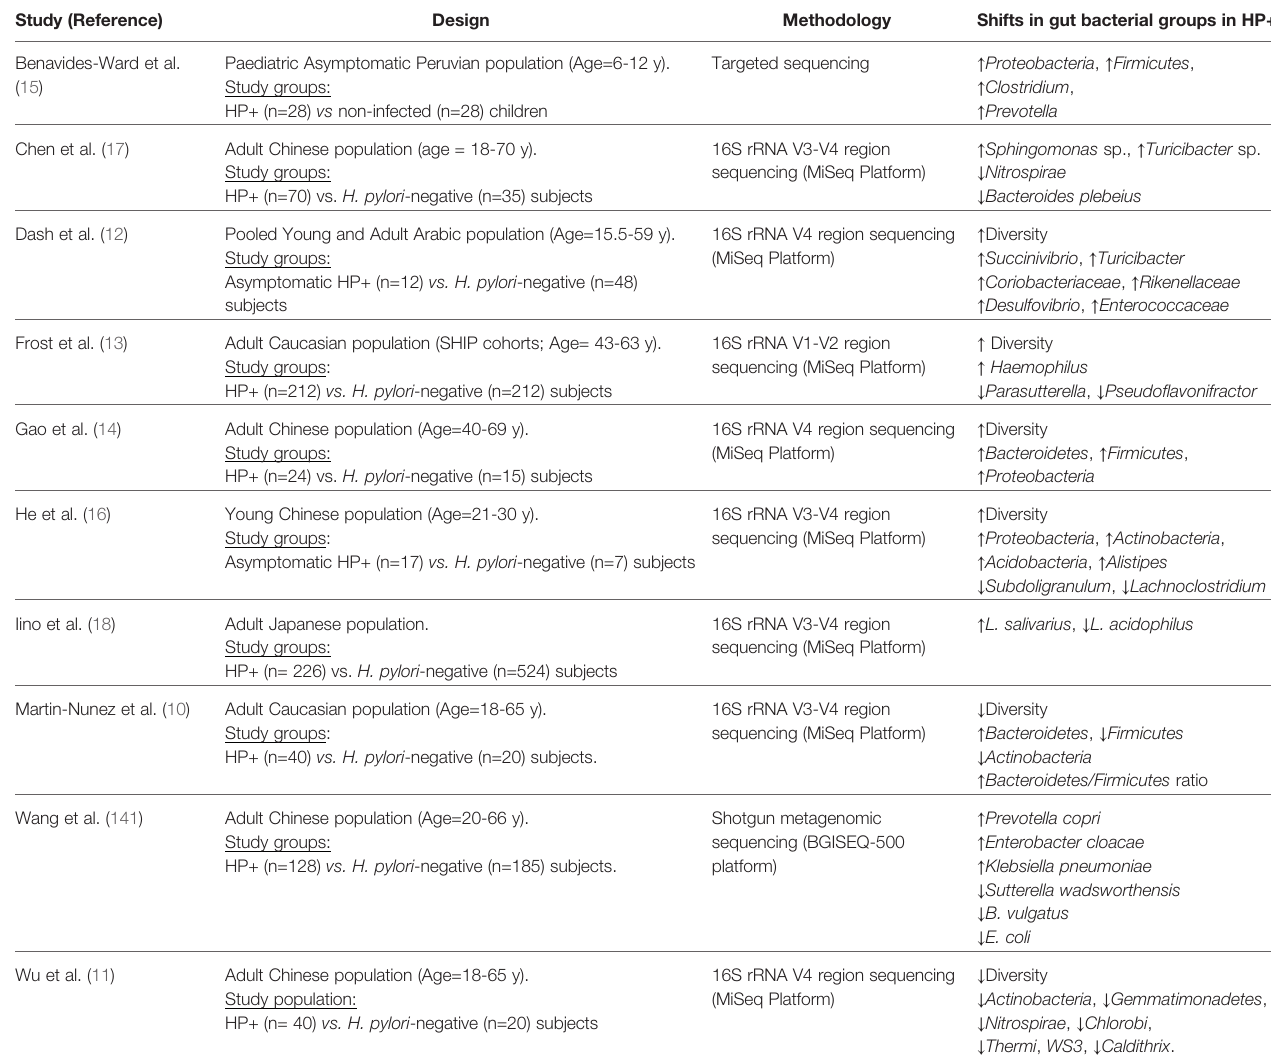
Targeted sequencing ↑ Proteobacteria , ↑ Firmicutes , ↑ Clostridium ,